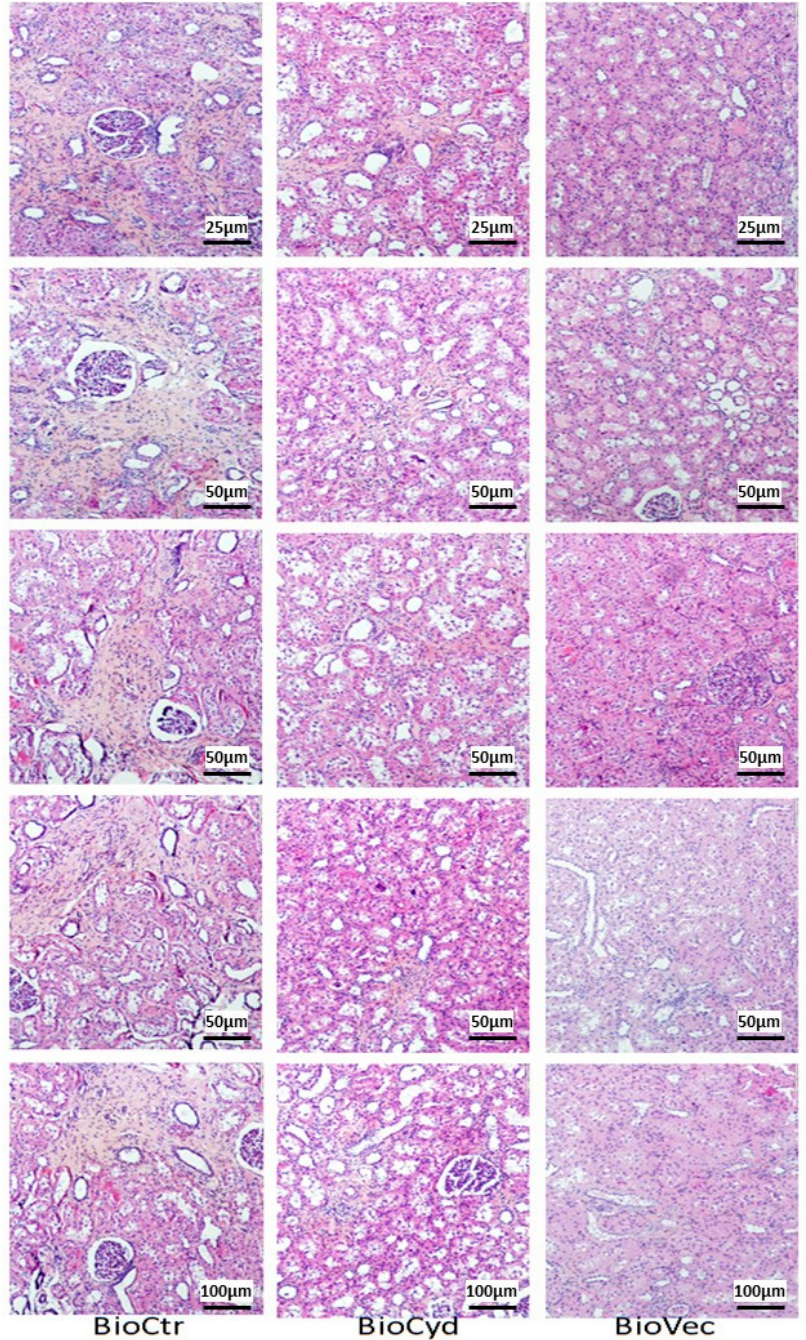
Figure 7. Representative images of histology at the end of the follow-up. Animals were euthanized after three months’ follow-up and cortical samples were formalin fixed and processed for PAS (Periodic Acid Schi ff ) staining. Each column represents a group, displaying several areas of the sample at the indicated